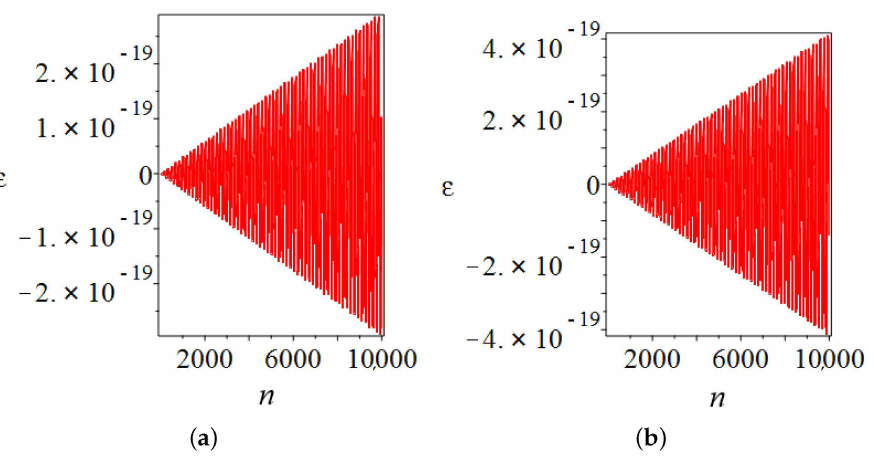
) / ϕ Figure 8. Error ε = ( ϕ i − ϕ analytic 20 of Greenspan II method over timestep index for ( a ) ϕ 1 and i ( b ) ϕ 2 angles obtained in a multistep procedure with the fixed time step T = 0.02 (the dimensionless periods of the natural oscillations are 0.0861 and